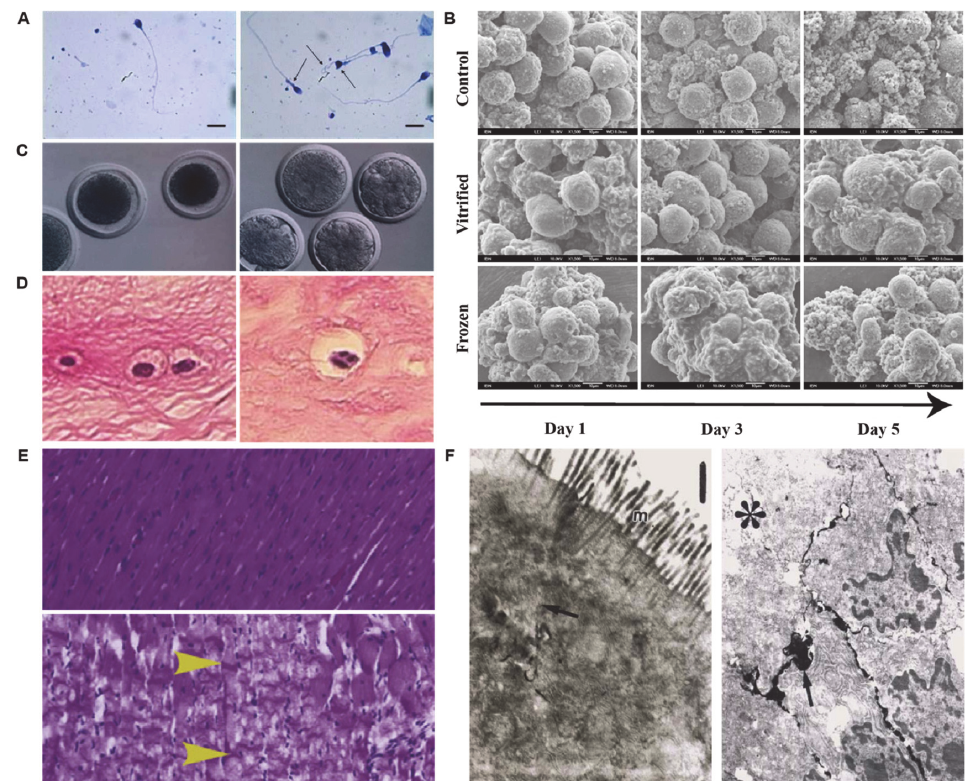
Figure 1. The morphology of cryopreserved cells. ( A ) Representative morphology of fresh (left) and cryopreserved (right) sperm. The arrows indicate abnormal morphology. Scale bars are 10 µm. Adapted with permission from Ref. [65]. Copyright 2021, Elsevier. ( B ) SEM images taken on Days 1, 3 and 5 of control, vitrified, and frozen HSs. Adapted with permission from Ref. [67]. Copyright 2012, Elsevier. ( C ) Detection of apoptosis in cryopreserved bovine oocytes by morphological charac- terization and biochemical characterization. Adapted with permission from Ref. [68]. Copyright 2003, Elsevier. ( D ) The morphology of fibrochondrocytes in fresh and cryopreserved meniscus. Adapted with permission from Ref. [69]. Copyright 2011, Springer Nature. ( E ) Hematoxylin and eosin stains of the tissue taken from the left ventricle of healthy hearts or preserved under a variety of conditions. Adapted with permission from Ref. [70]. Copyright 2018, Elsevier. ( F ) Photomicrographs at the EM level of the small bowel of a rat that was not stored or stored for 12 h with RL solution. Adapted